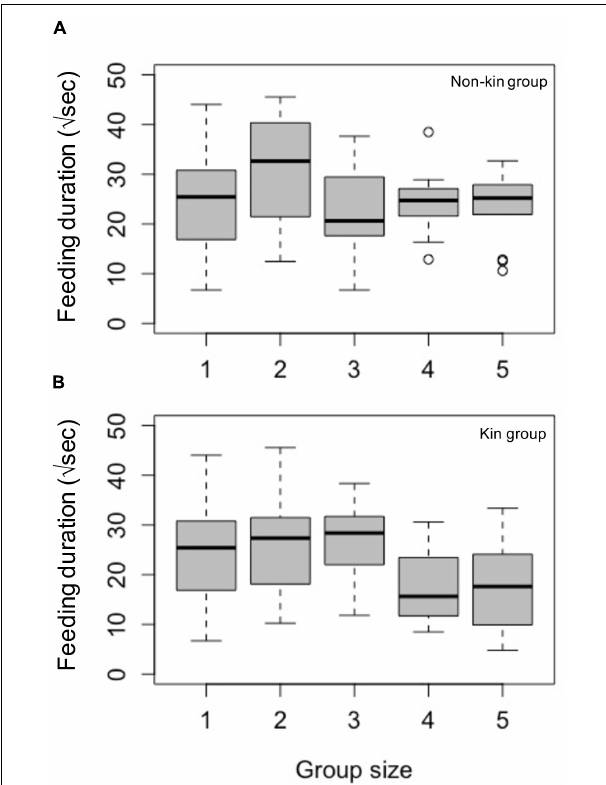
FIGURE 1 | Feeding duration (in seconds, square root transformed) as a foraging benefit in different group sizes of (A) non-kin and (B) kin laboratory assembled groups. Results shown that under the conditional model, where the zeros were removed, the feeding duration for the successfully fed Argyrodes showed nonsignificant difference among group sizes, including with the largest group size five. The data in non-kin groups showed a trend toward a peak in feeding duration in group size two, whereas kin groups do not have this trend. The samples sizes were: Group size one: n = 12; group size two: n = 8 for non-kin group and n = 19 for kin group; group size three: n = 8 for non-kin group and n = 7 for kin group; group size four: n = 12 for non-kin group and n = 4 for kin group; group size five: n = 13 for non-kin group and n = 7 for kin